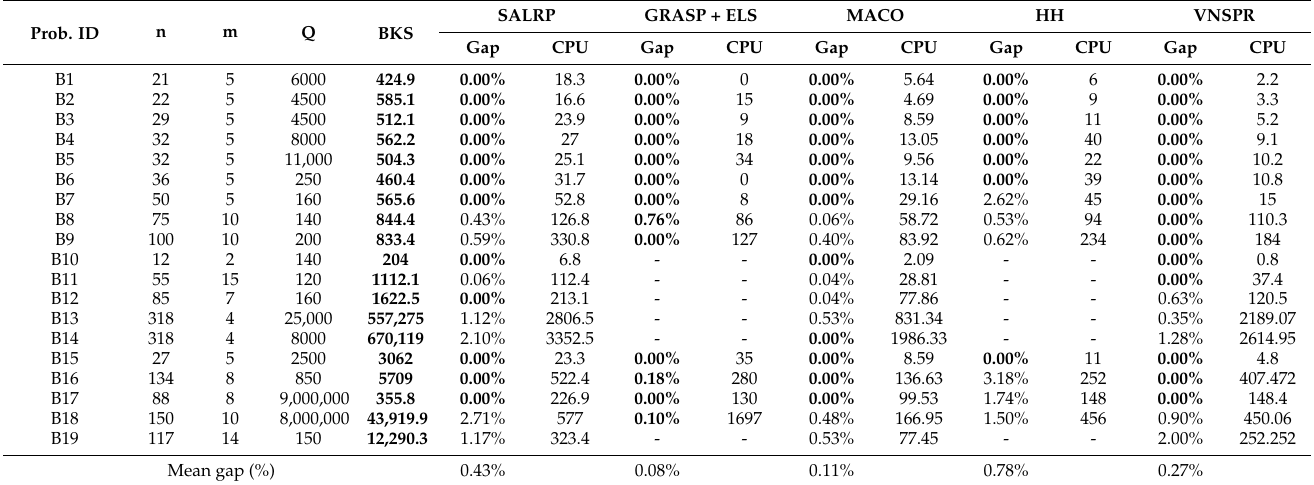
Table 2. Results of CLRP for the Barreto’s [41] instances.